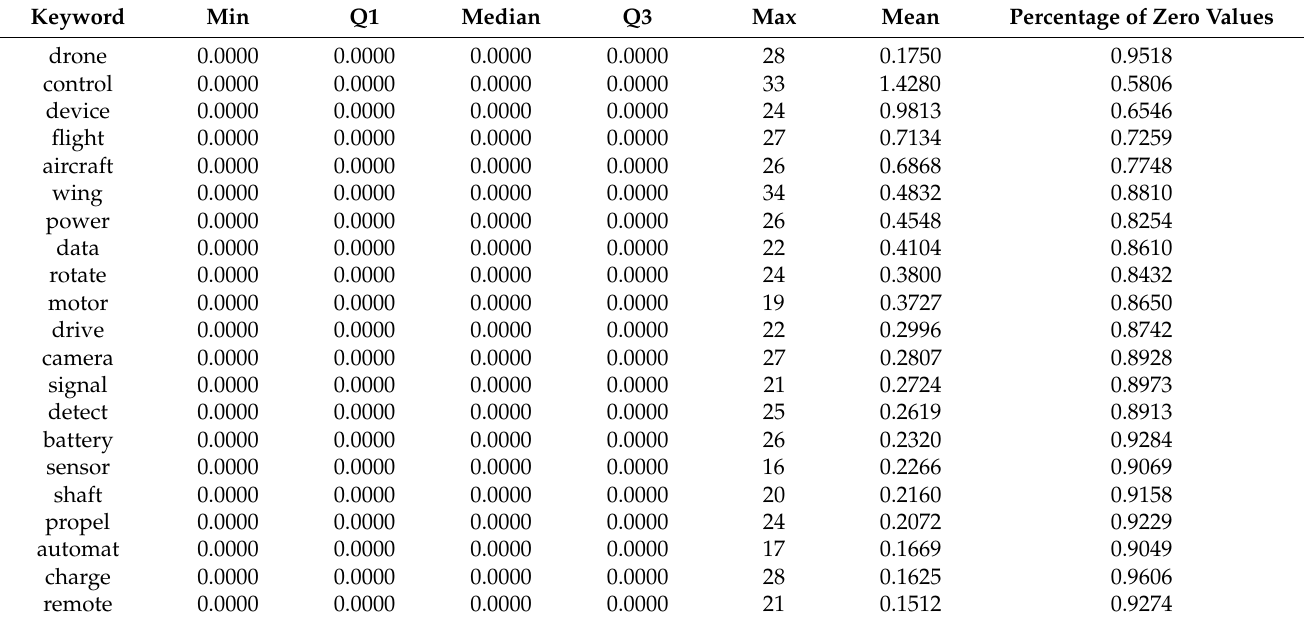
Table 4. Summary statistics of patent data.